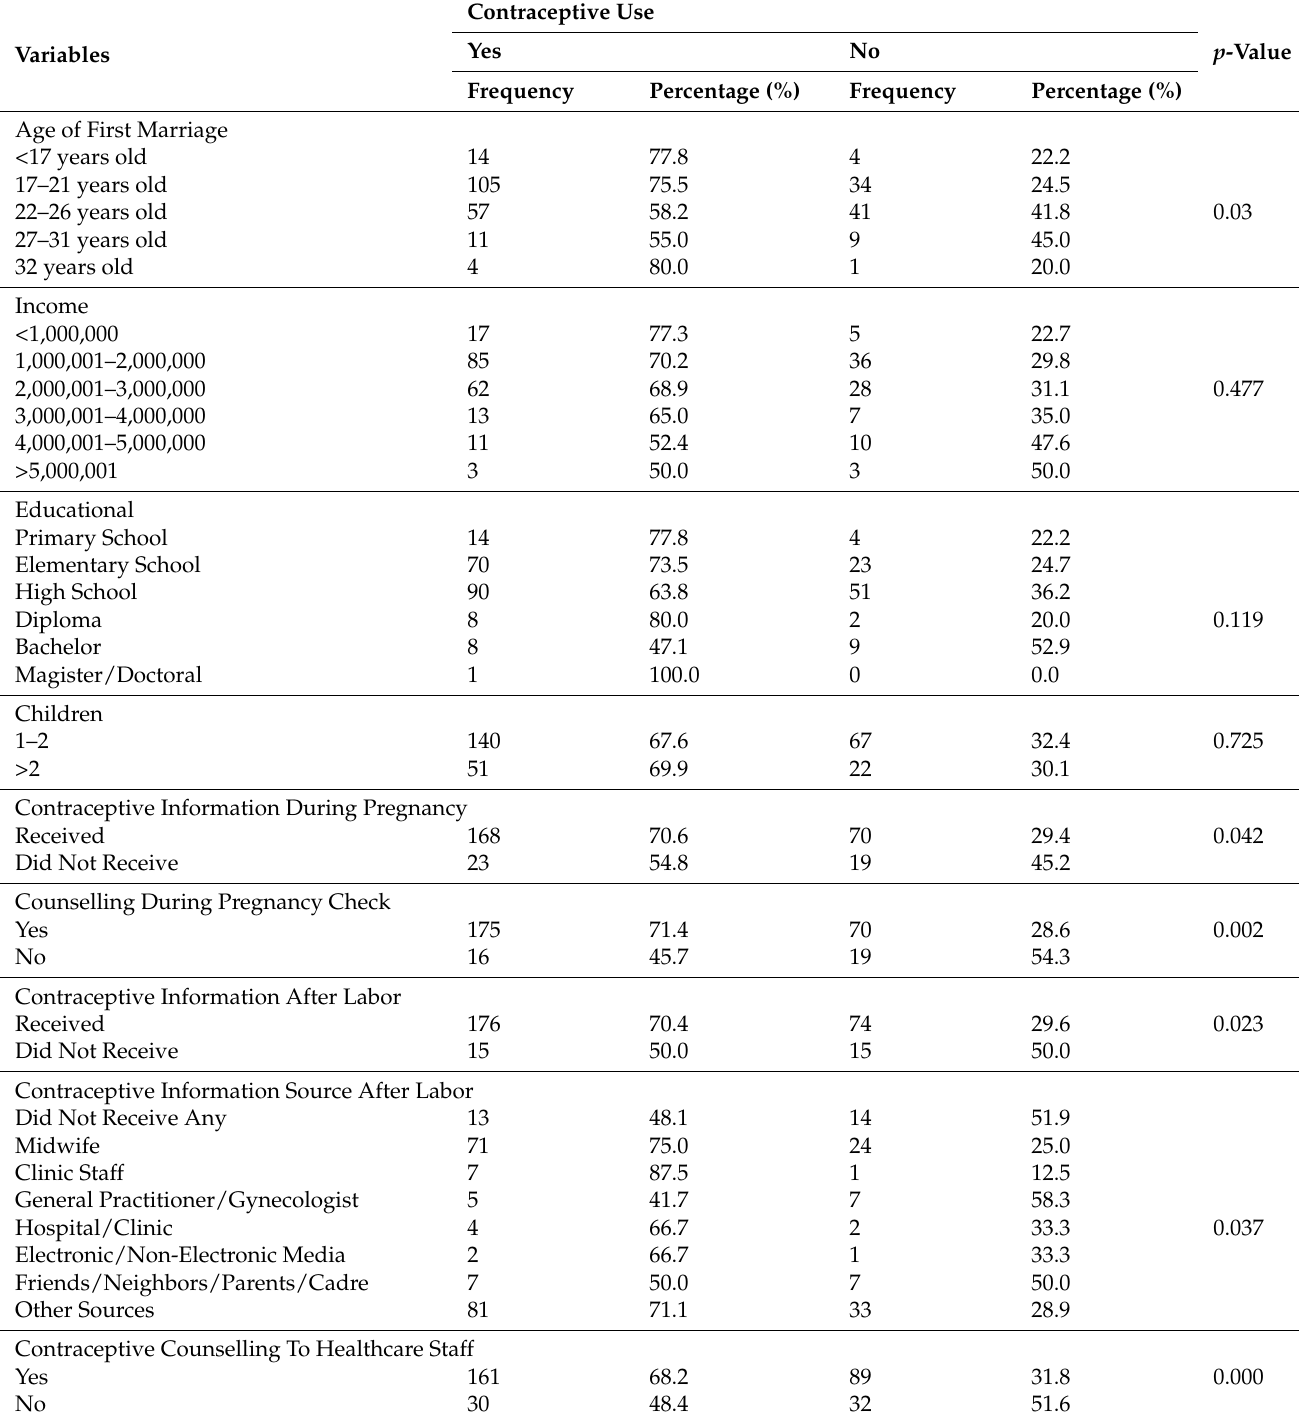
Table 3. The relationship between predisposing factors, enabling factors, and reinforcing factors using the